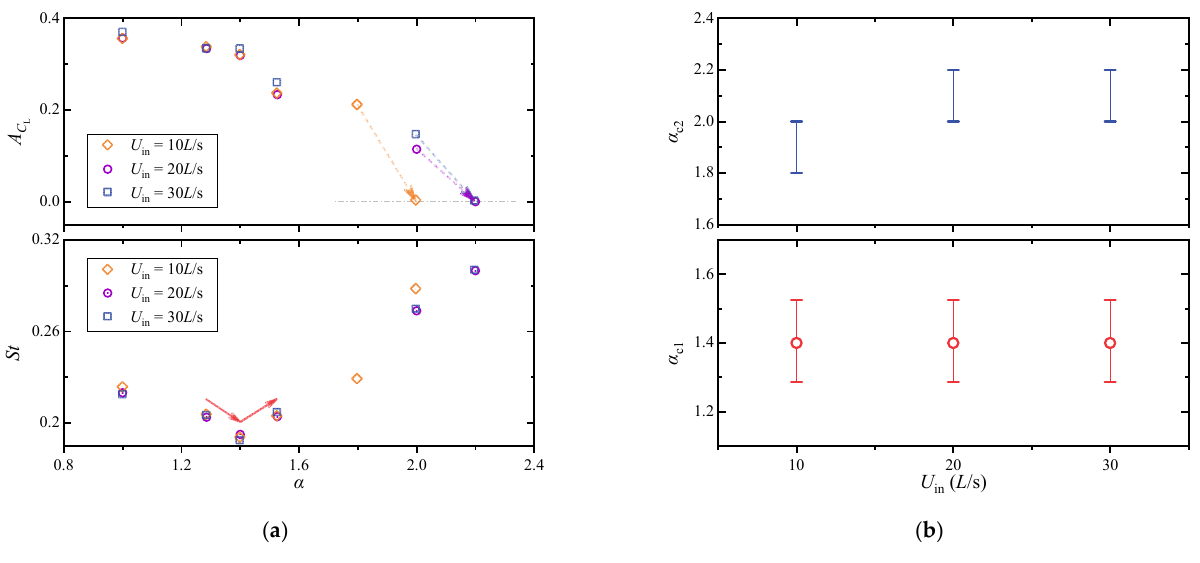
A and St , and ( b ) range of α c1 and and St , and ( b ) range of α c1 and α c2 . L